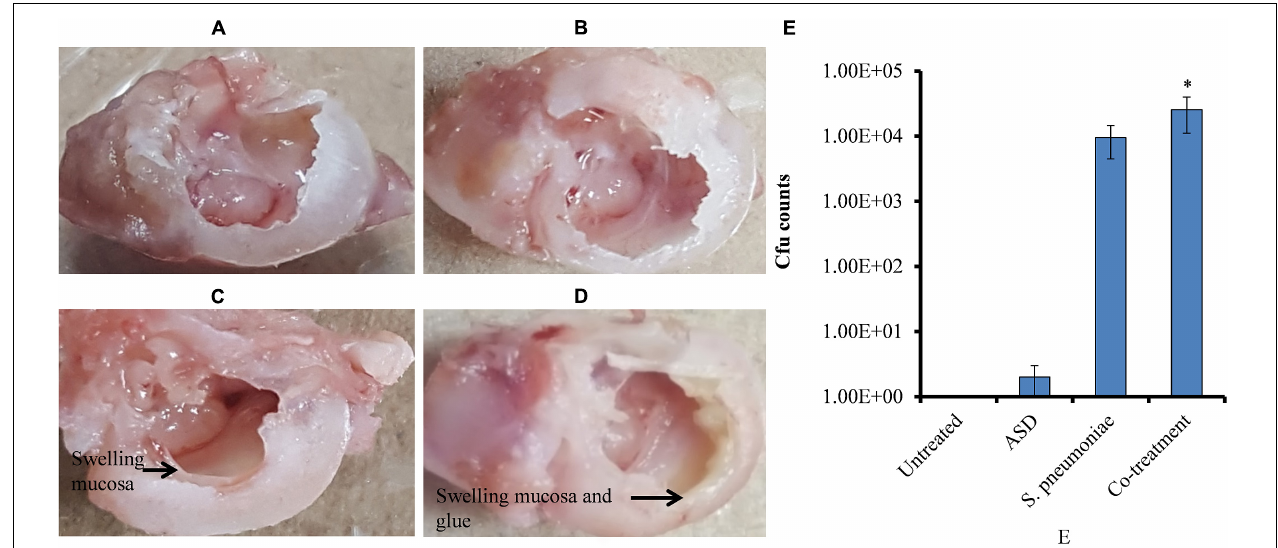
FIGURE 7 | (A–D) Digital photograph of rat middle ear injected with ASD or S. pneumoniae of co-treatment. (E) Cfu counts of rat middle ear inoculated with ASD or S. pneumoniae or co-treatment. The error bars representing standard deviation from mean, and statistical significance were calculated by one-way ANOVA and ∗ P value less than 0.05 was considered